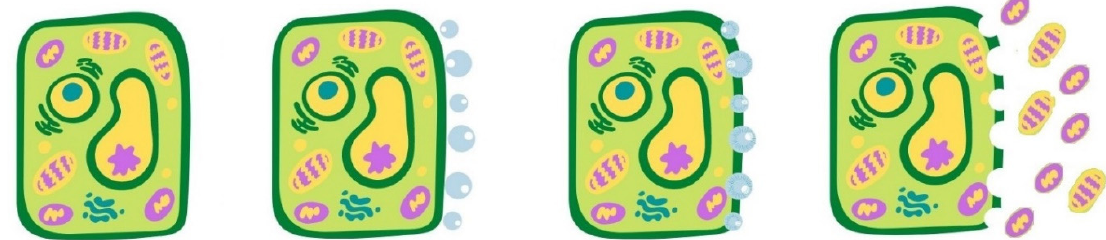
Figure 3. Mechanism of cell rupture induced by ultrasounds: cavitation bubble generation, bubble collapse, and cell wall fragmentation.